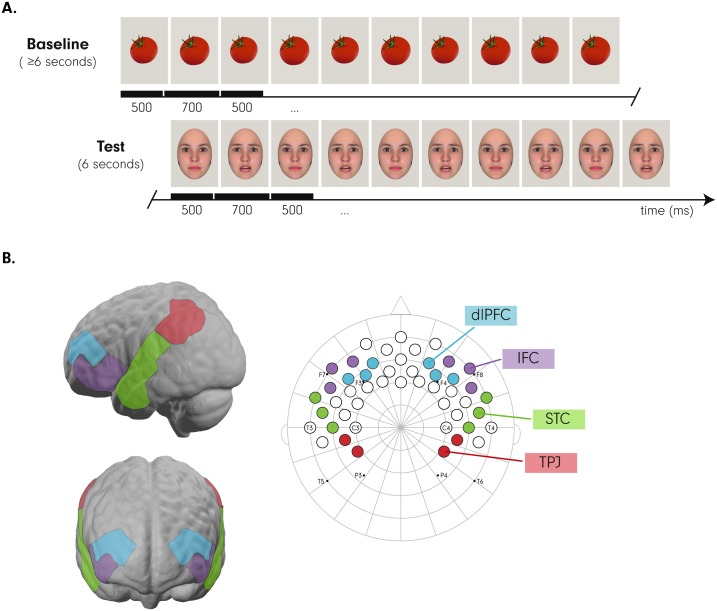
A: This illustrates the fNIRS paradigm employed in the current study at age 7 months. Note that the fNIRS experiment preceded the eye tracking experiment. Infants viewed at least 6 seconds of nonsocial (inanimate) baseline stimuli followed by 6 seconds of emotional (happy, angry, and fearful) test stimuli. Dynamically changing stimuli were administered by presenting neutral faces that rapidly and repeatedly changed to one of the 3 emotions. B: This shows the fNIRS channel layout (right) with the nose plotted up and the 3 ROIs marked by different colors (dlPFC = blue; IFC = violet; STC = green; TPJ = red) on the left with reference to the 10–20 system commonly used in EEG research. On the left, these ROIs are also shown when projected onto the cortical surface of a frontal-view (bottom) and lateral-view brain (top). Please note that infants viewed photographic images of real faces (see Materials and methods) and that the facial images shown here were computer generated with the FaceGen software (https://facegen.com) for illustrative purposes. EEG, electro-encephalography; fNIRS, functional near-infrared spectroscopy; IFC, inferior frontal cortex; ROI, region of interest; STC, superior temporal cortex; TPJ, temporo-parietal junction.